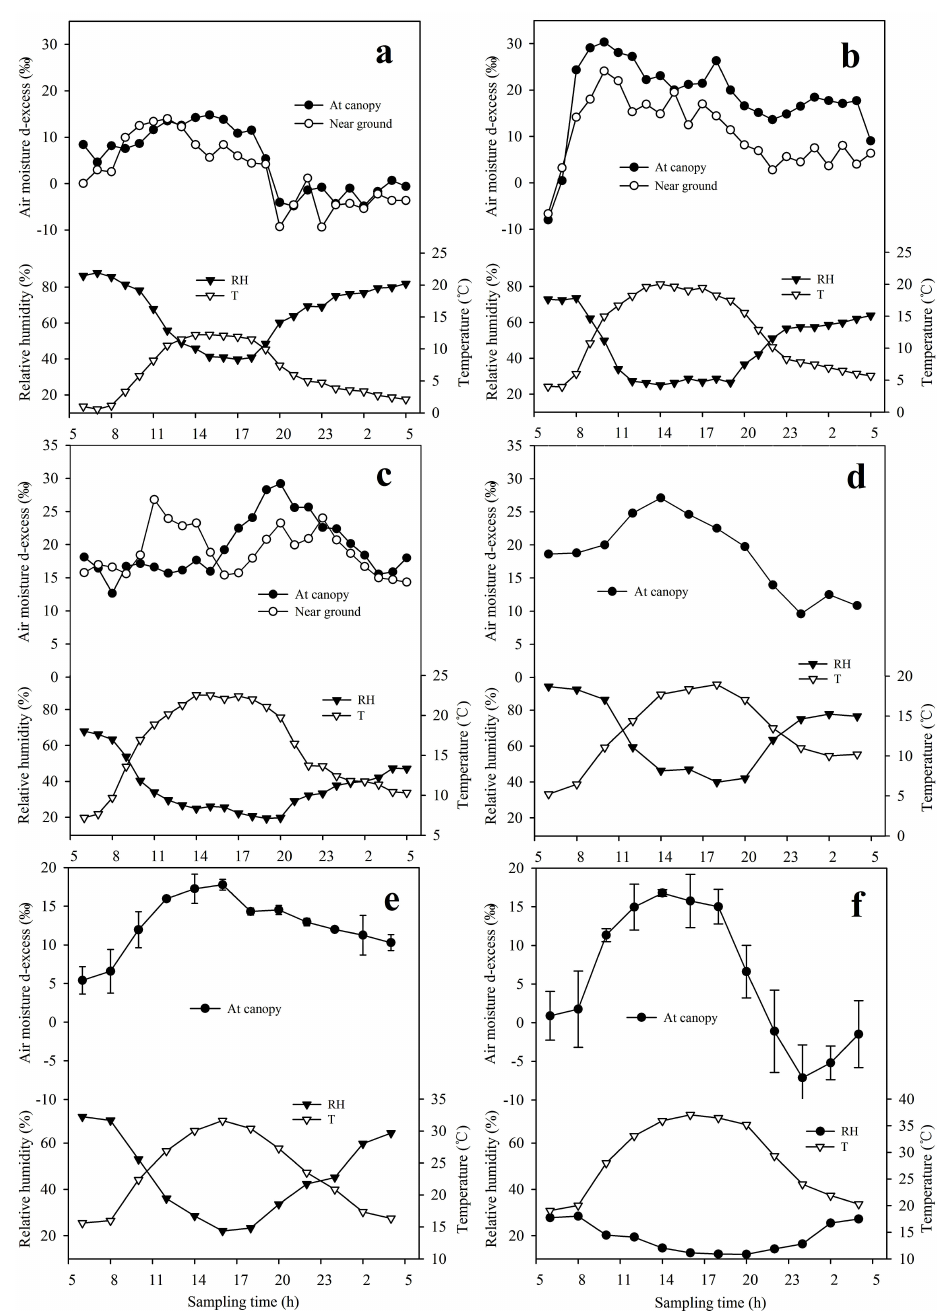
Figure 6. The d-excess of air moisture during the sunny days. Note: panels (a) , (b) , (c) , (d) , (e) and (f) refer to the same locations as in Fig. 2.